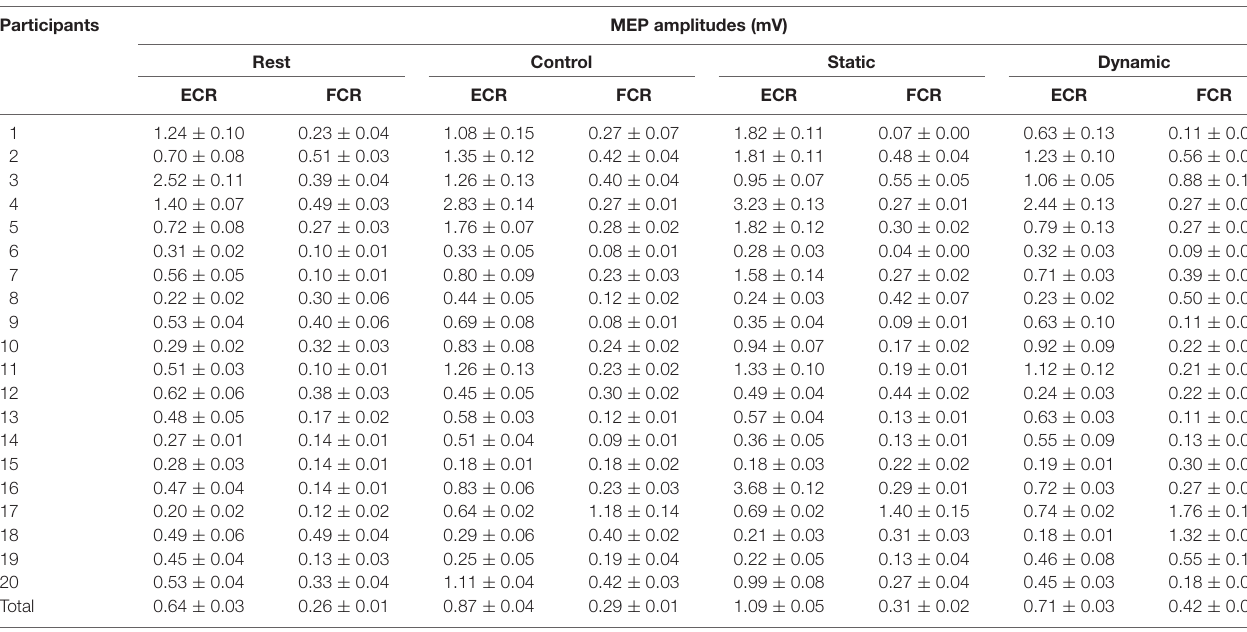
TABLE 1 | MEP amplitudes corresponding to the multisensory conditions. Participants MEP amplitudes (mV) Rest Control